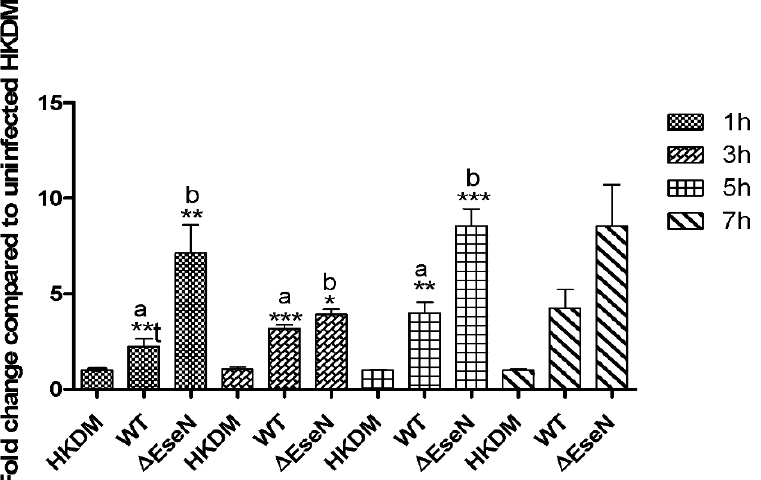
Figure 6. Expression of COX-2 mRNA. Data were analyzed by Rosh LightCycler ® 96 qPCR software using relative expression method. CanX and SDHA were used as reference genes. Comparison be- tween groups was based on One-way ANOVA with the Bonferroni procedure for comparison of group means. Comparison between two groups was also analyzed by t -test (t); Each column represents the mean ± SE of 3 to 4 independent experiments (depend on time points of infection); a: indicates significant difference between HKDM-WT (WT) and uninfected HKDM (HKDM), b: indi- cates significant difference between HKDM-WT (WT) and HKDM- ∆EseN (∆EseN) * p < 0.05, ** p < 0.01, *** p < 0001.